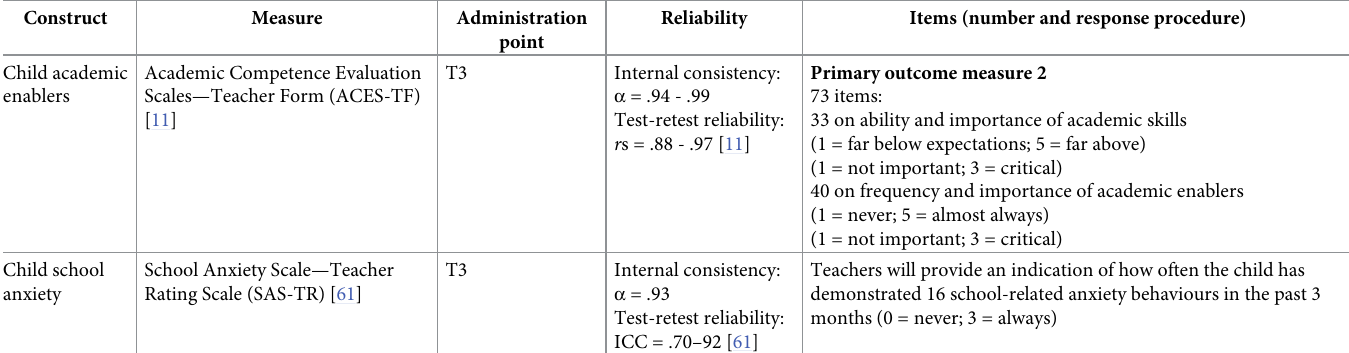
Table 3. Teacher measures used in